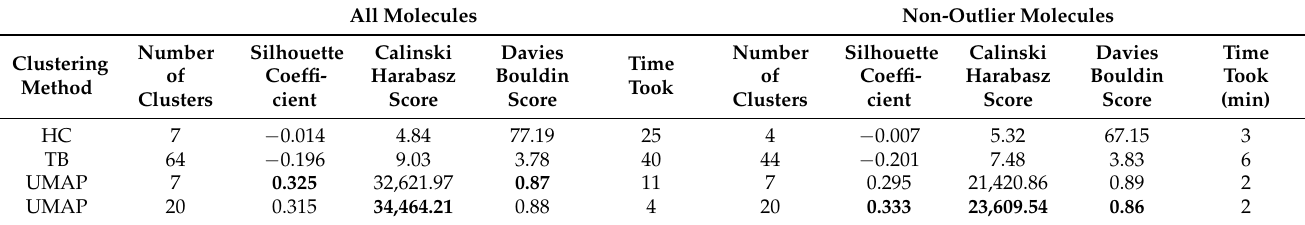
Table 7. UMAP clustering outperforms results obtained by hierarchical and Taylor–Butina clustering. Comparison of the clustering quality metrics for each clustering algorithm. Non-outlier molecules were retrieved at an outlier cutoff of 0.5. The best value for each metric for either all molecules or non-outlier molecules is highlighted in bold. For readability, clustering quality results were rounded to either two or three decimal